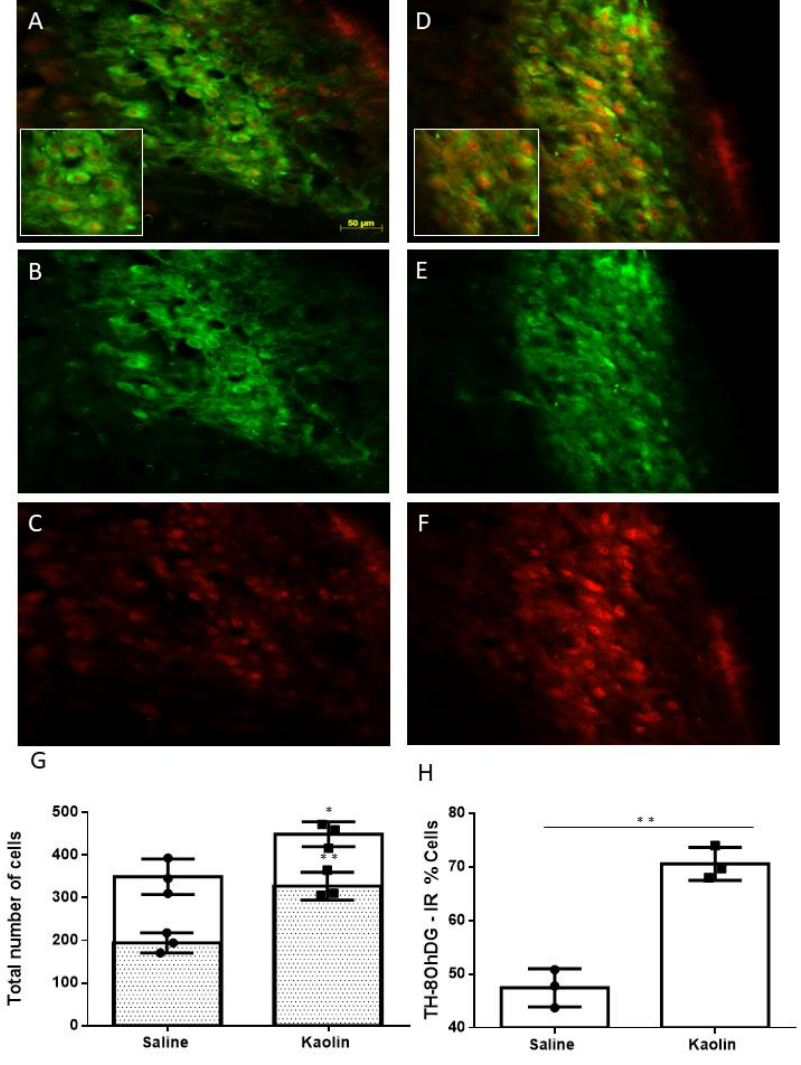
Figure 4. Co-localization of TH and 8-OHdG in the LC. Representative immunofluorescence photomi- crographs from a saline-injected animal ( A – C ) and kaolin-injected animals ( D – F ) of the same section double-labelled for 8-OHdG and TH ( A ) or observed in a single channel for TH ( B , E ) or 8-OHdG ( C , F ). The inset in ( A , D ) shows the detail of neurons double-immunolabeled for TH (green) and 8-OHdG (red). Graph G shows the total numbers of 8-OHdG-IR neurons (white bars) or double-labelled for 8-OHdG and TH (grey bars). Graph H shows the percentage of TH-IR neurons that were also immunoreactive for 8-OHdG. Kaolin-injected animals presented an increase in the expression of 8-OHdG and co-localization of 8-OHdG in TH-IR neurons in the LC. Saline: n = 3; Kaolin: n = 3. Data in ( G , H ) are presented as means ±SEM.* p < 0.05; ** p < 0.01.